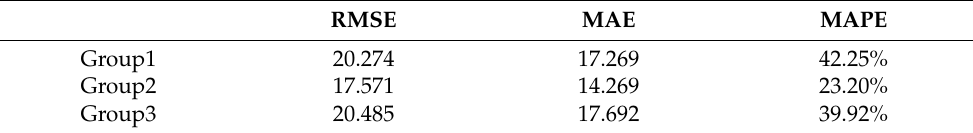
Table 10. Prediction performance of test set of time series